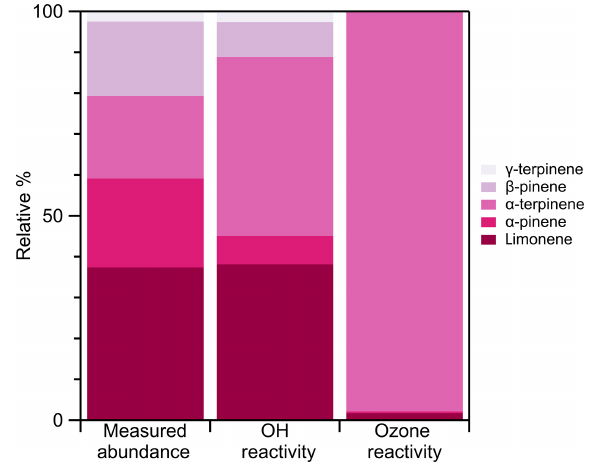
Figure 10. Relative measured abundance of all quantified monoter- penes from ginkgo leaf 1 (Fig. 9) and the subsequent relative con- tribution to both OH reactivity and ozone reactivity. OH and ozone reactivity were calculated using k OH and k ozone rate constants from Atkinson